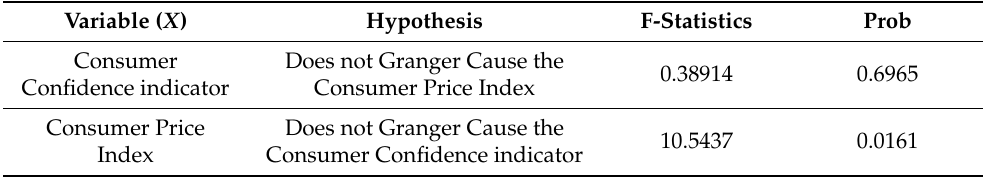
Table 2. Granger Causality test related to Unemployment rate/Consumer Price Index in Germany (DEU) for a period of 12 months from the beginning of the pandemic (with a lag of 2 months). Variable ( X ) Hypothesis F-Statistics Prob Consumer Does not Granger Cause the 0.38914 0.6965 Confidence indicator Consumer Price Index Consumer Price Does not Granger Cause the 10.5437 Index Consumer Confidence indicator